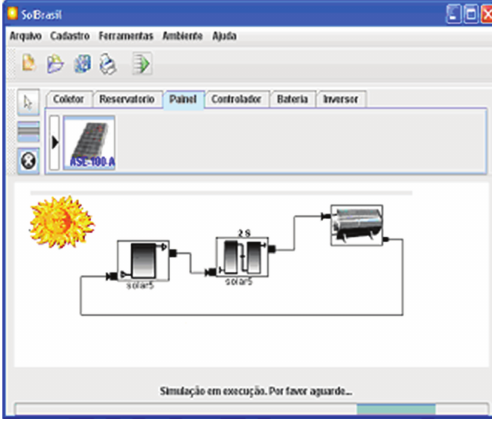
Figure 6: An instance for thermosiphon simulation.